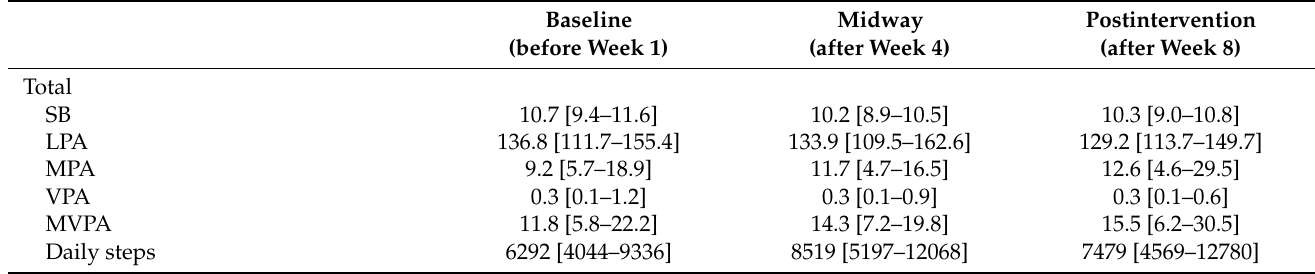
Table 4. Secondary outcomes on objectively measured habitual physical